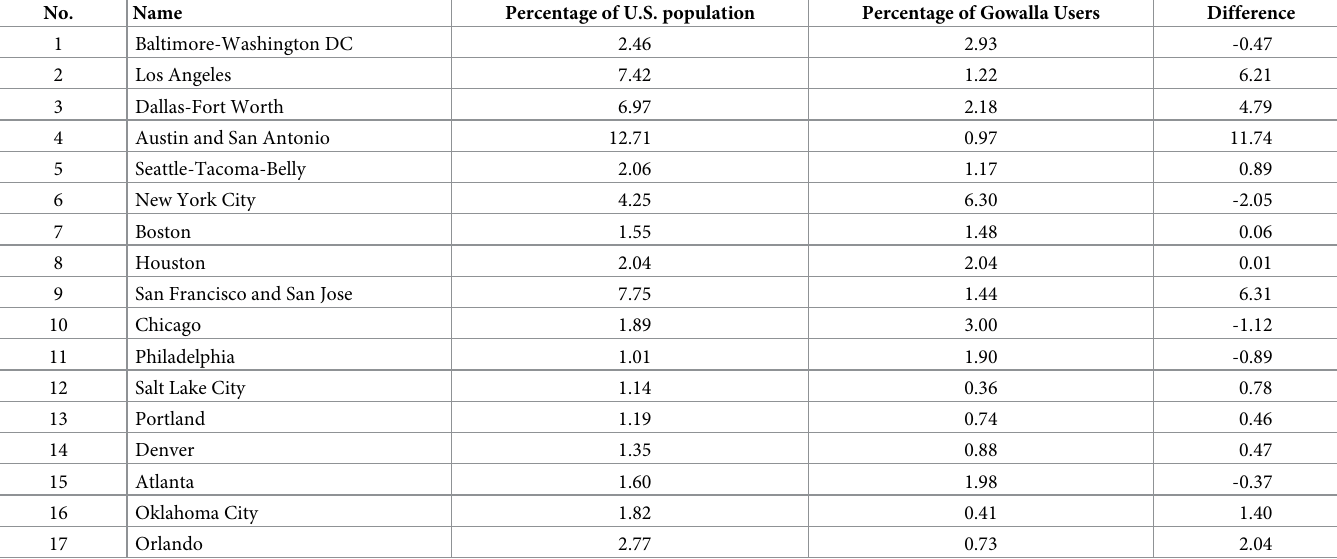
Table 1. Percentages of Gowalla users and the populations of metropolitan areas in the United